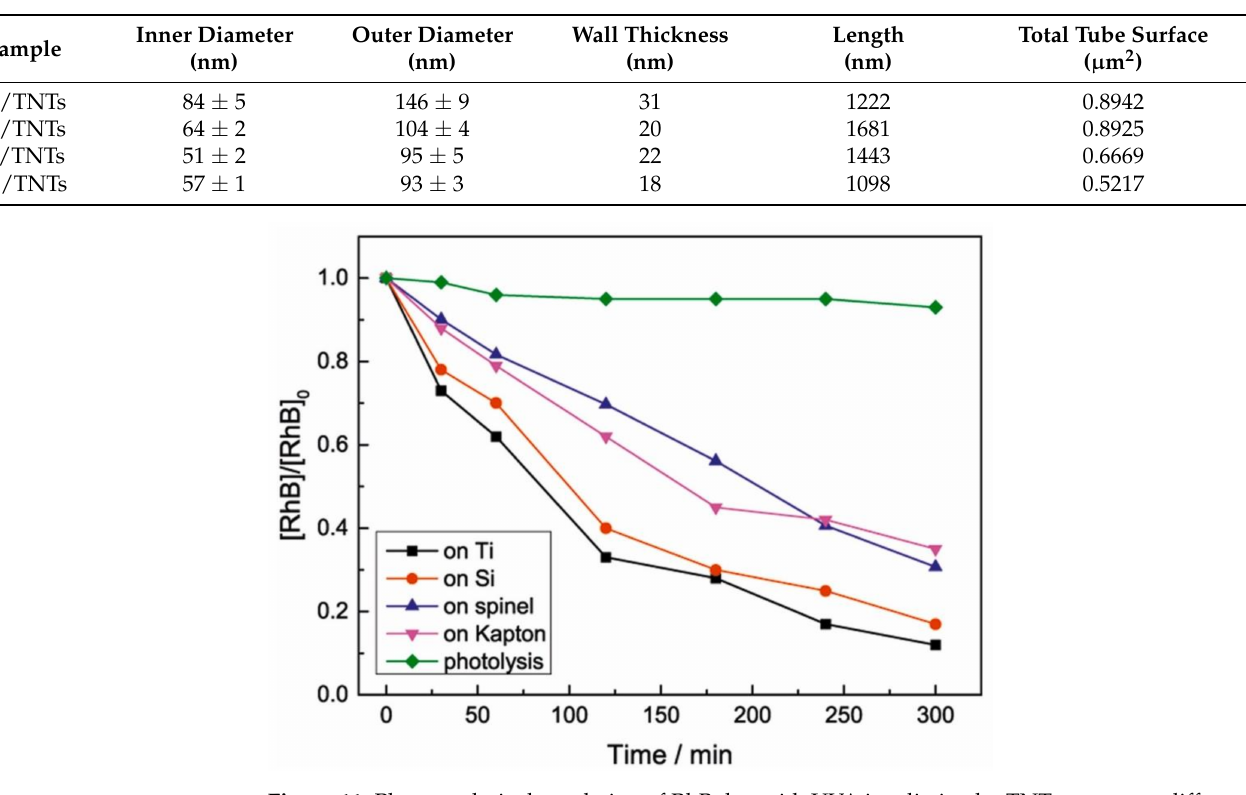
Table 1. Geometrical features of TNTs prepared on different substrates: ceramic spinel (M), Si wafer